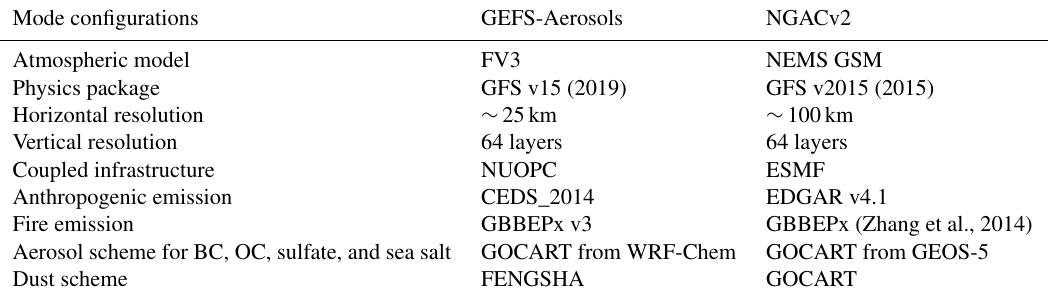
Table 2. Comparison of model configurations between GEFS-Aerosols and